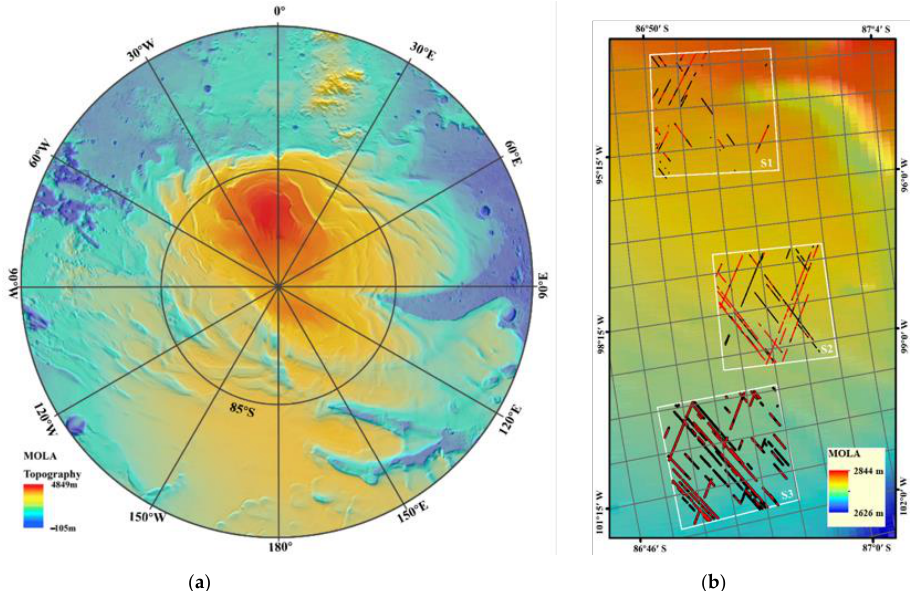
Figure 3. Study regions in the south pole of Mars: ( a ) Topography of the south pole of Mars provided by MOLA. The white square in the picture is the study area; ( b ) Enlarged display of the study area. From top to bottom are S1, S2, S3, respectively. The red and black points are the trajectories of the radar data. The red points are the data used for analysis, and the black points are the data that were